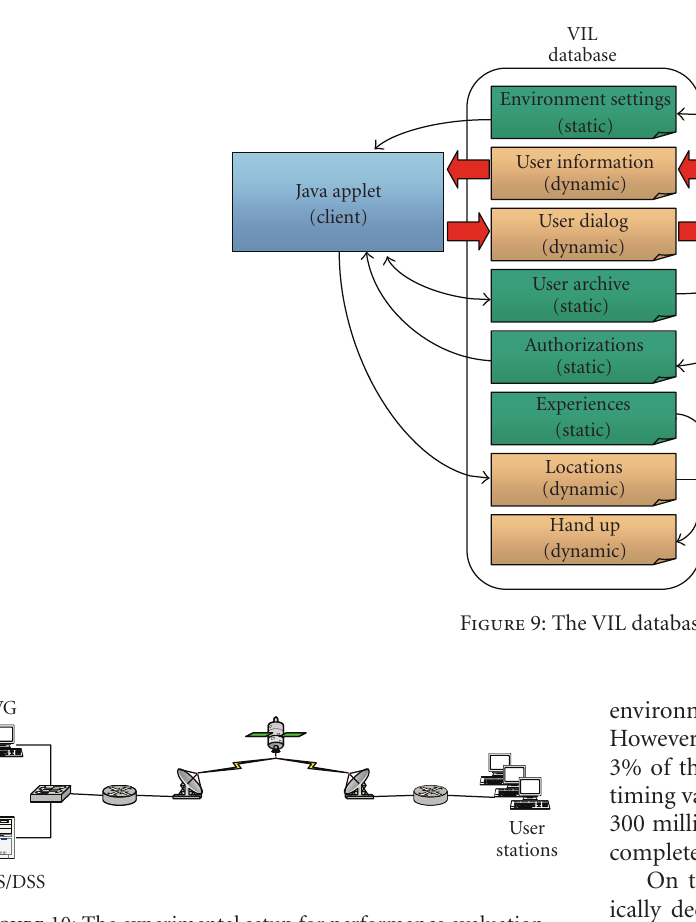
Figure 10: The experimental setup for performance